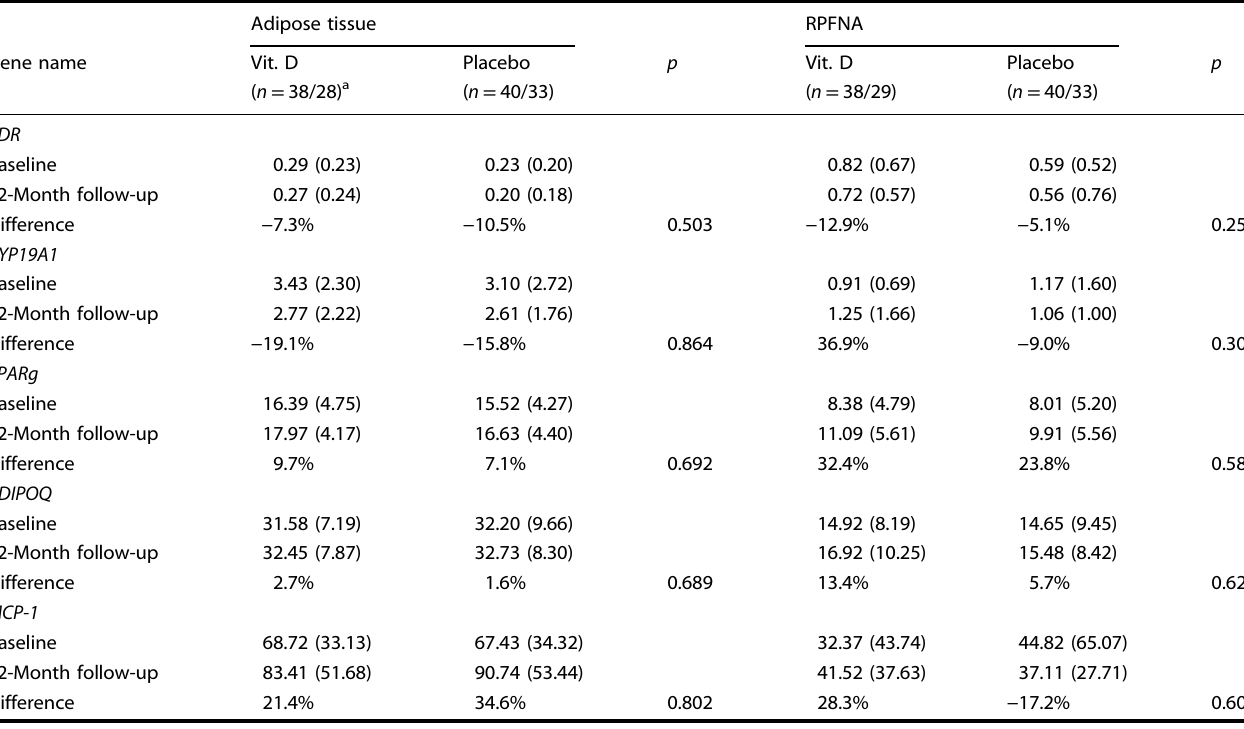
Table 2. Twelve-month change in gene expression (unsupervised) in women randomized to daily vitamin D (2000 IU) vs. placebo Adipose tissue